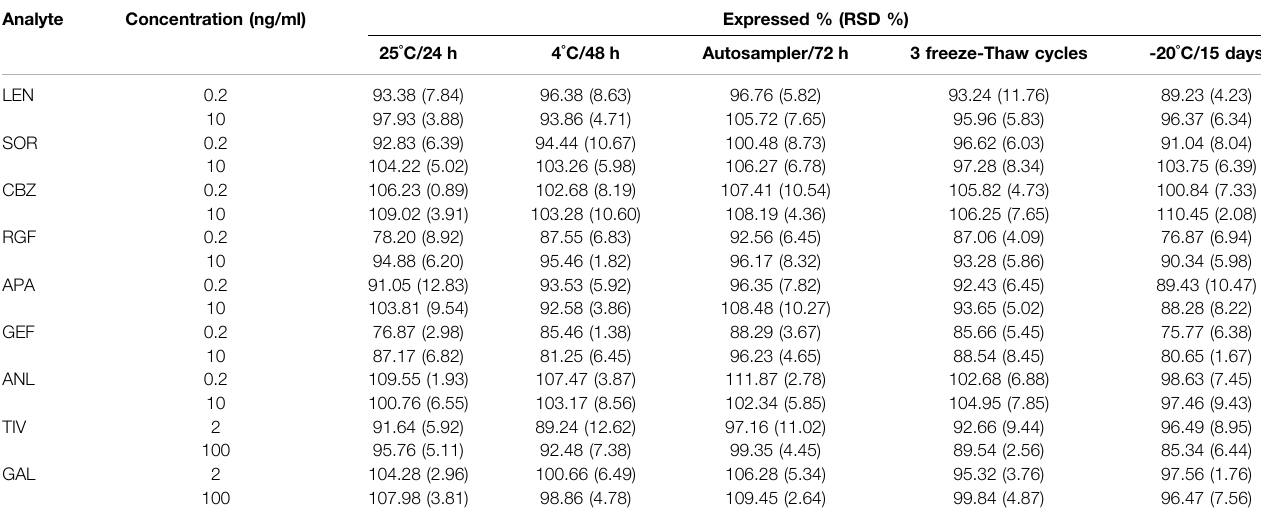
TABLE 5 | Stabilities of the LQC and HQC samples under different storage conditions ( n = 6).